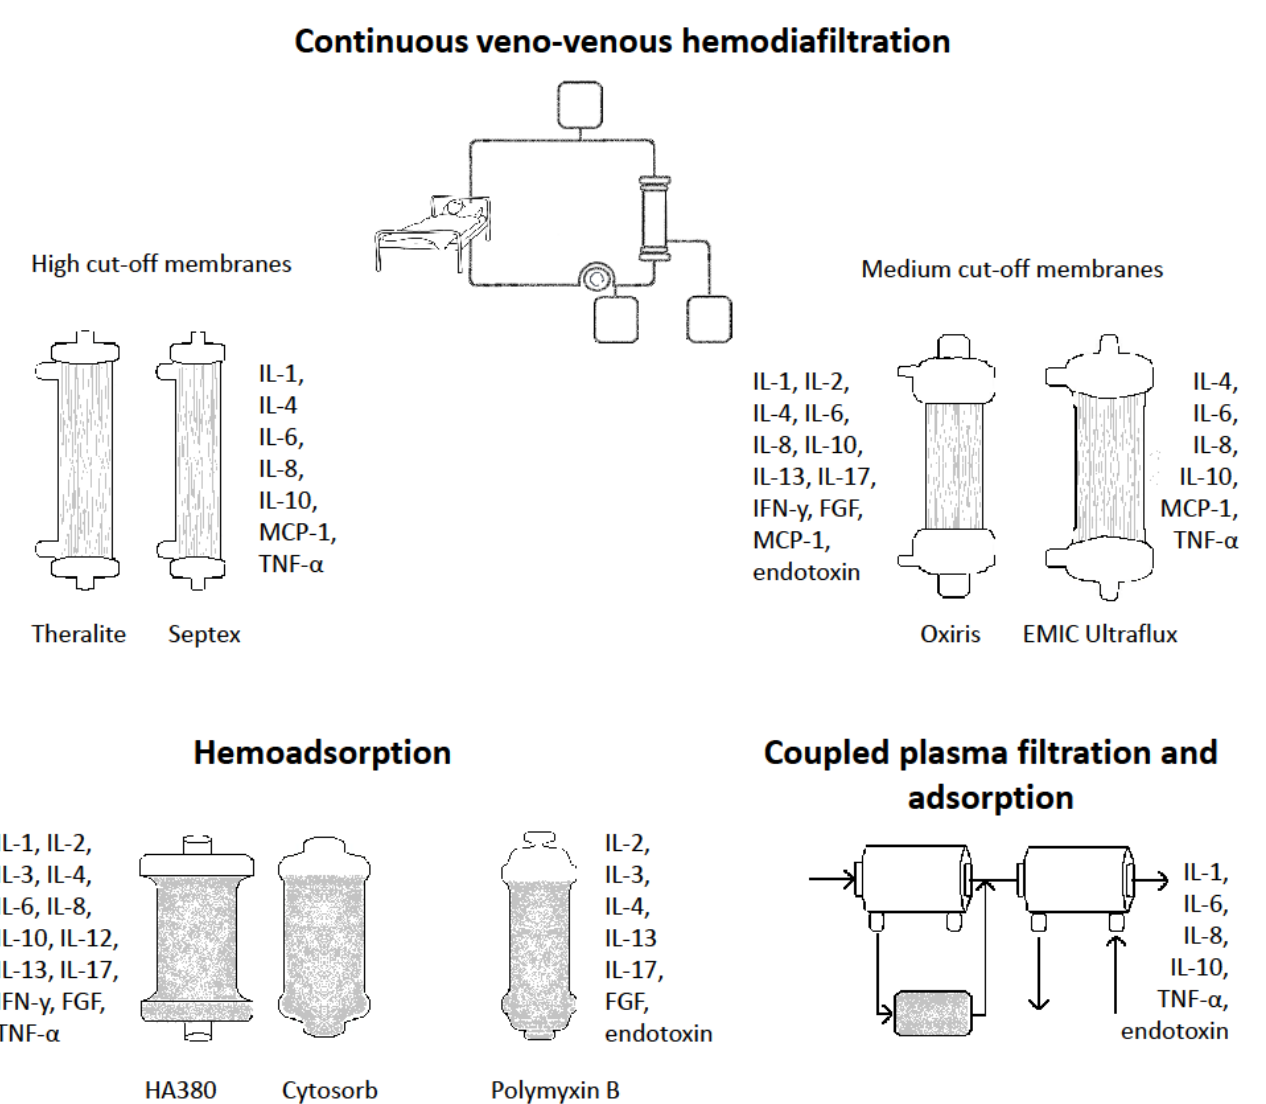
Figure 2. Current evidence on the clearance and adsorption of cytokines and endotoxins by different blood purification techniques. IL, interleukin; IFN, interferon; FGF, fibroblast growth factor; TNF, tumor necrosis factor; MCP, macrophage chemoattractive protein.